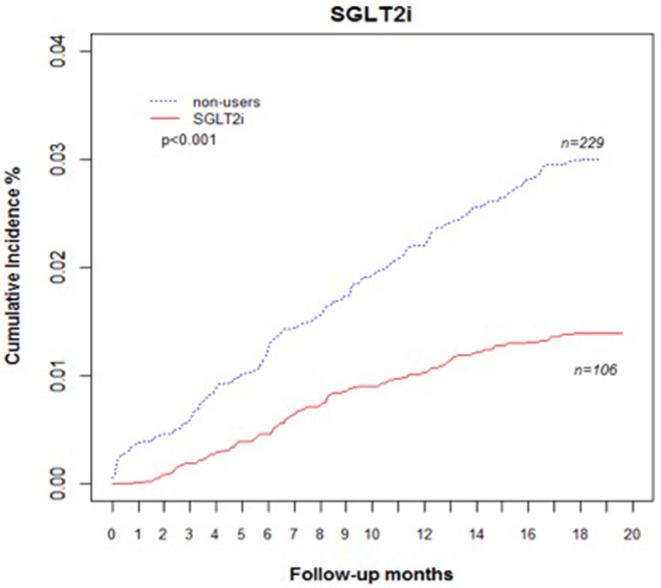
Cumulative incidence rate of decrease in eGFR over 40% in patients with diabetes. Outcomes were estimated according to history of eGFR decrease over 40% for SGLT2 inhibitor users vs. non-users. eGFR, estimated glomerular filtration rate; SGLT2i, sodium–glucose cotransporter 2 inhibitor.